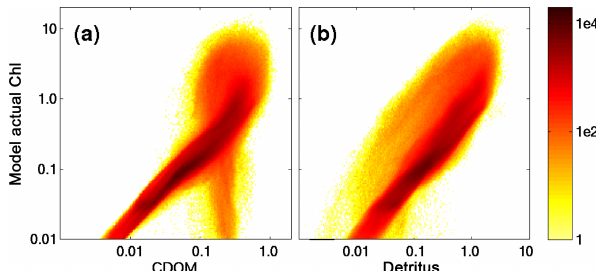
Figure 10. Two-dimensional histogram of model output for “actual” Chl a (mgm − 3 ) plotted against (a) model CDOM (mmolCm − 3 ) and (b) detritus (mmolCm − 3 ). The colour indicates the log of the fraction of all data that occur in bins in the phase space (the light yellow reflects a single instance in that